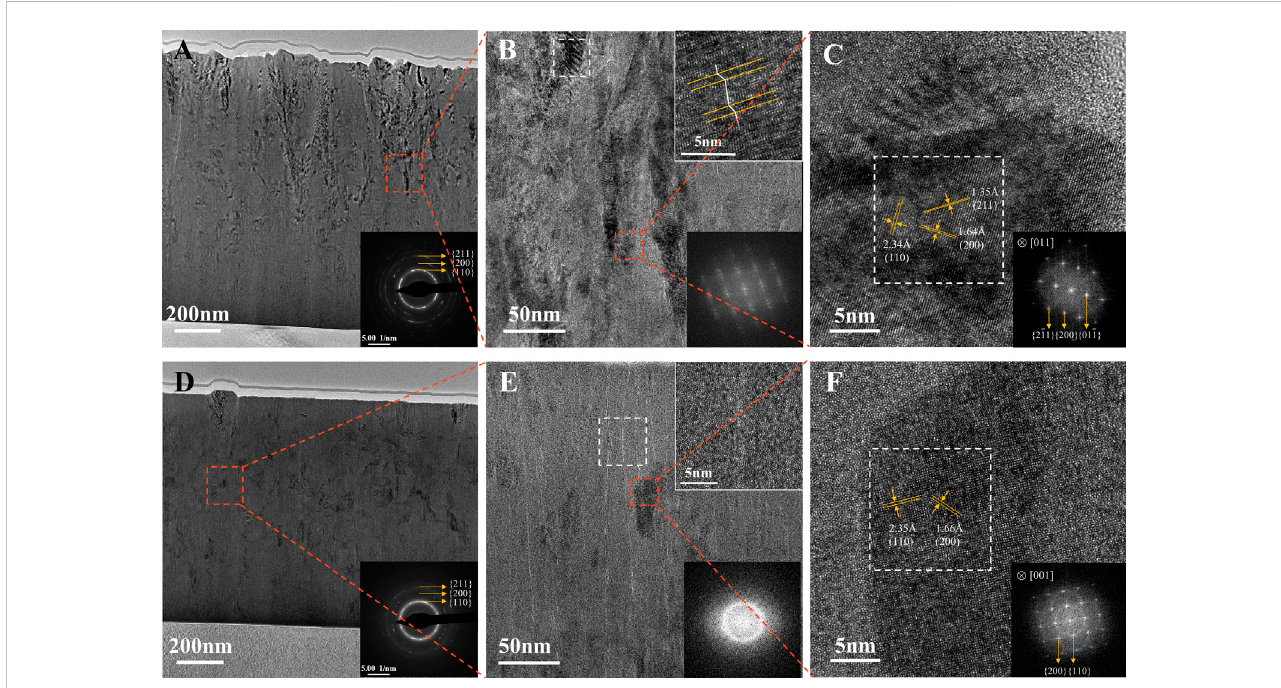
FIGURE 4 Cross-section microstructure of the ZrNbTiMo RHEA fi lms: (A,D) TEMimages with SAED patternsof the fi lm depositedat150 W and 210 Wrespectively, (B,E) magni fi ed TEM images, (C,F) HRTEM images with FFT patterns corresponding the characteristic regions marked by the white rectangles.